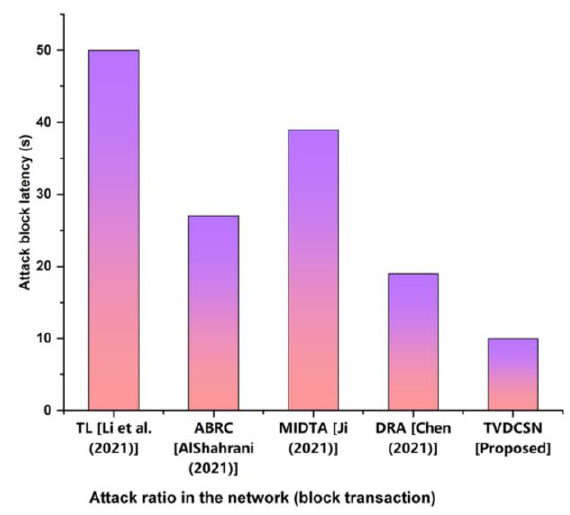
Figure 11. Block Generation Latency Based on Attack Transactions . Figure 10. Block Generation Latency Based on Attack